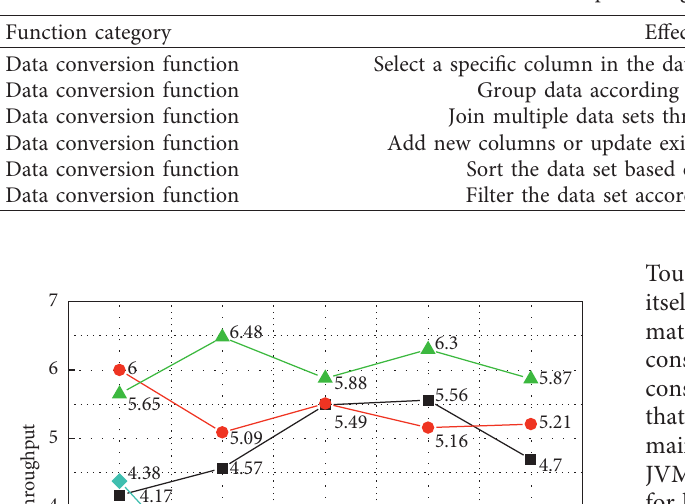
Table 1: Data processing